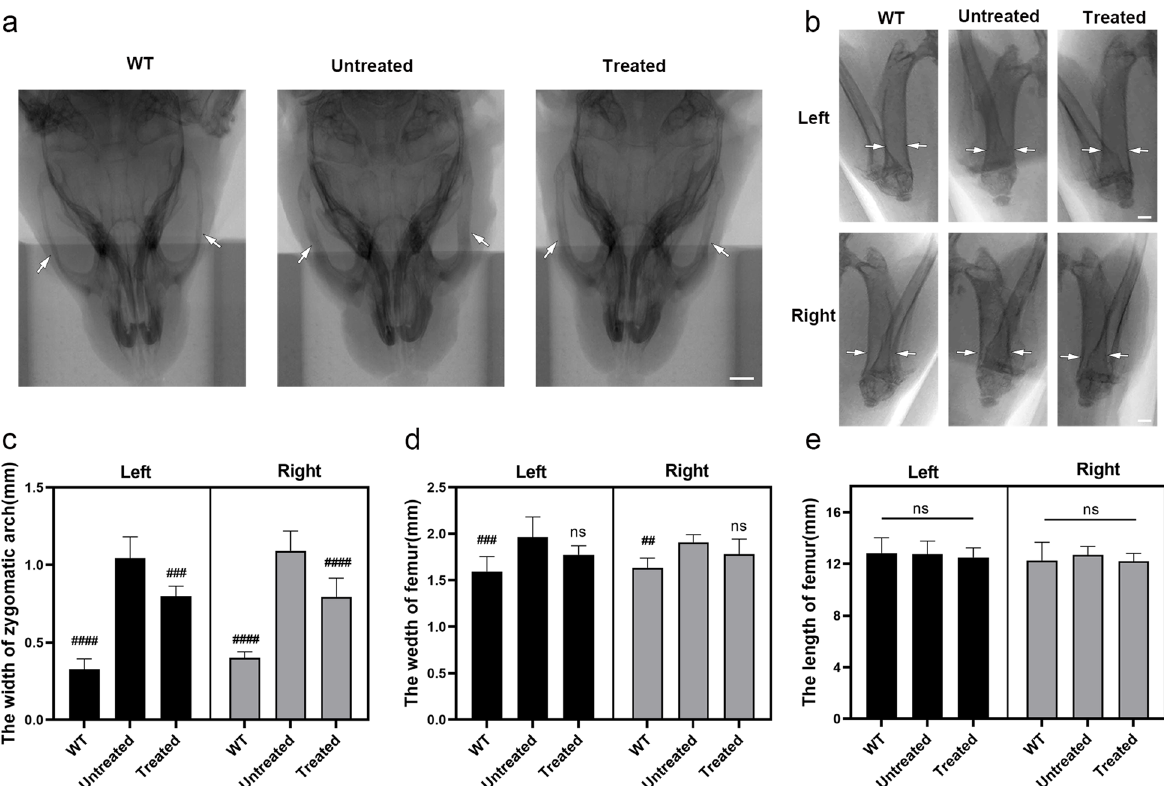
Fig. 4 In vivo base editing rescues skeletal abnormalities in MPS IH mice. a Representative micro-CT images of 32-week-old mice showing zygomatic arches (white arrows). The zygomatic arch widened significantly in untreated MPS IH mice. Scale bar, 2 mm. b Representative micro-CT image of a 32-week-old mouse showing the femur. The two white arrows in the same image indicate the width of the femur. Scale bar, 1 mm. c‑e Quantification of zygomatic arch width, femur width and femur length. Mean SD are shown, n 7 per each group. The WT mice and treated MPS ± = IH mice were compared with the untreated MPS IH mice, ## p < 0.01, ### p < 0.001, #### p < 0.0001, one-way ANOVA analysis with Tukey’s